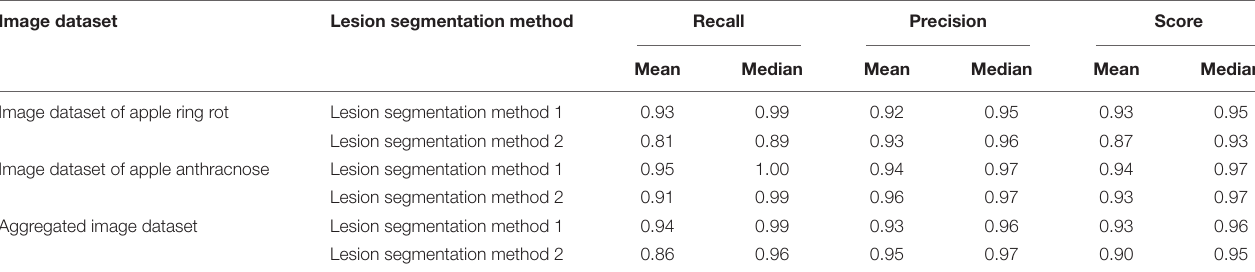
TABLE 1 | Statistical comparison of the segmentation effects using the two lesion segmentation methods. Image